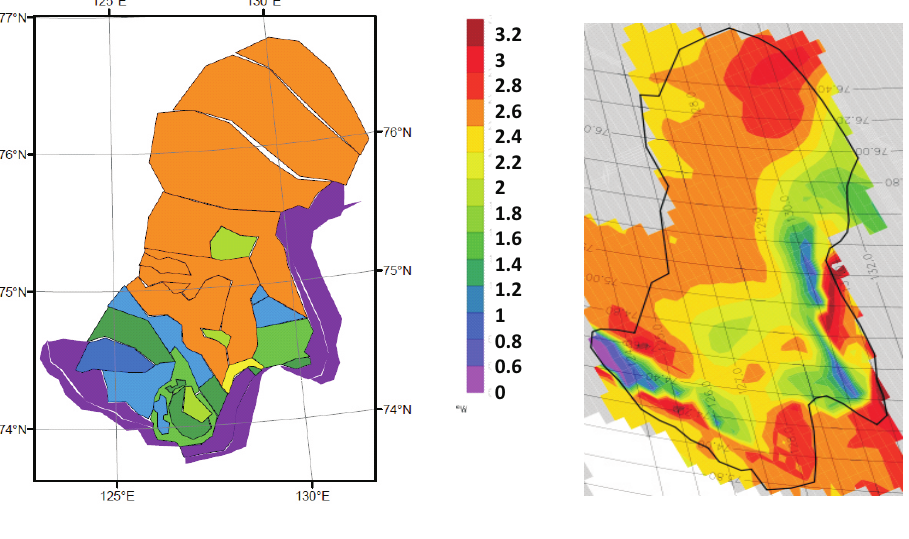
Fig. 8. Areas of sea ice that originated after polynya openings along the fast ice edge during the 116-day-long survey period. The color code refers to mean ice thickness. (a) Results from SAR tracking and HEM surveying. (b) Results from NAOSIM model.